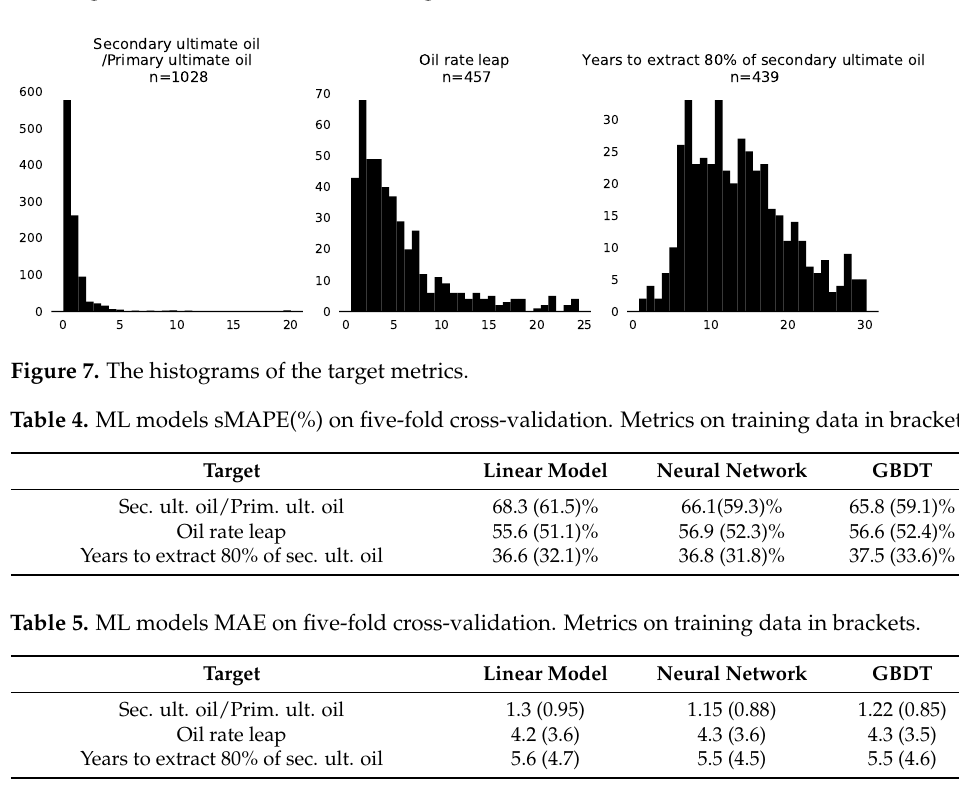
Table 6. ML models R 2 on five-fold cross-validation. Metrics on training data in